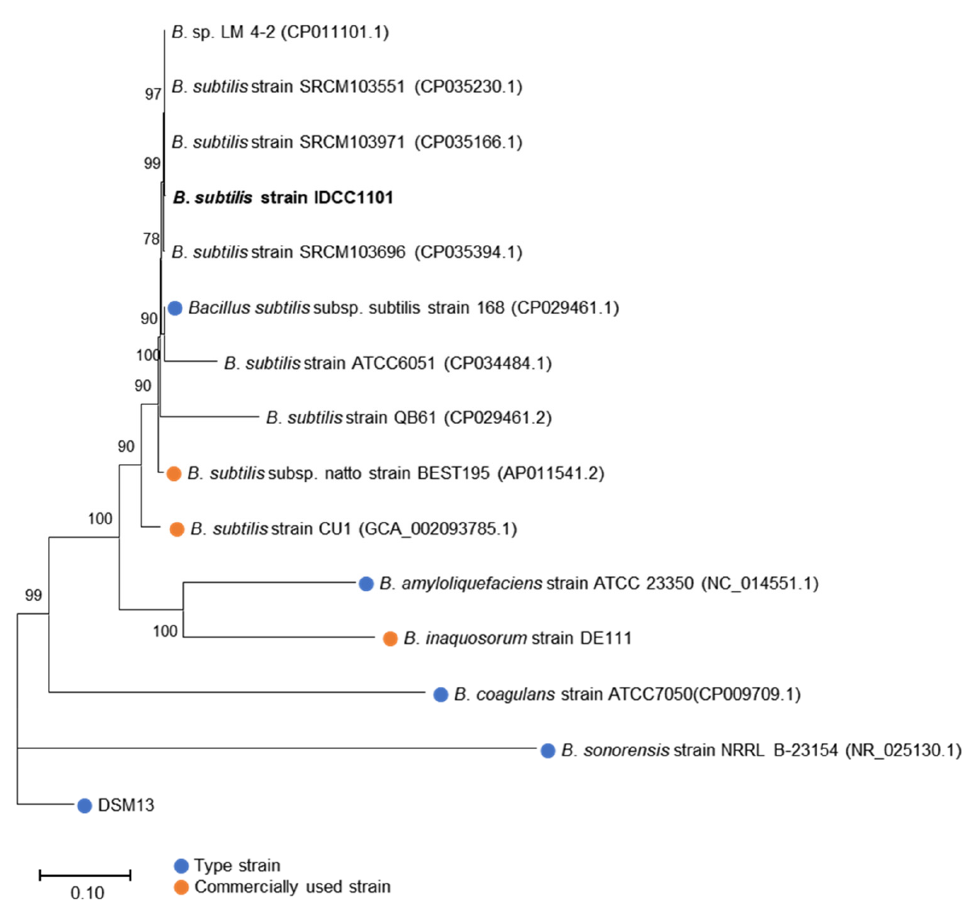
Figure 2. Phylogenetic tree of B . subtilis IDCC 1101 and 15 other Bacillus strains based on the concatenated housekeeping genes, including groEL , gyrA , polC , purH , rpoB , and 16S rRNA. The blue circles indicate bacterial type strains.